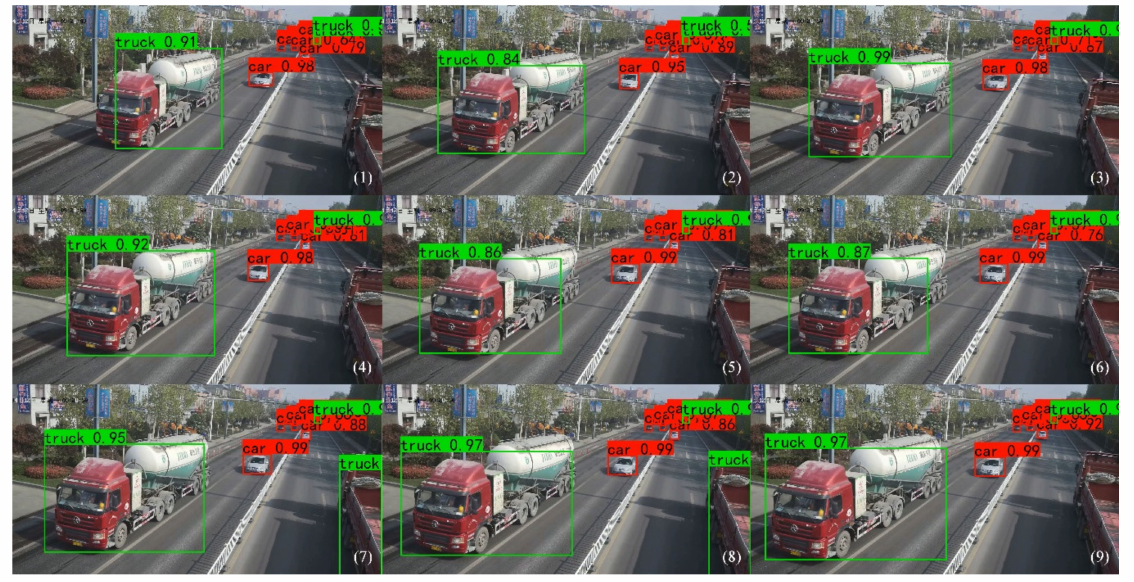
Figure 8. The detection effect of 9 consecutive frames.